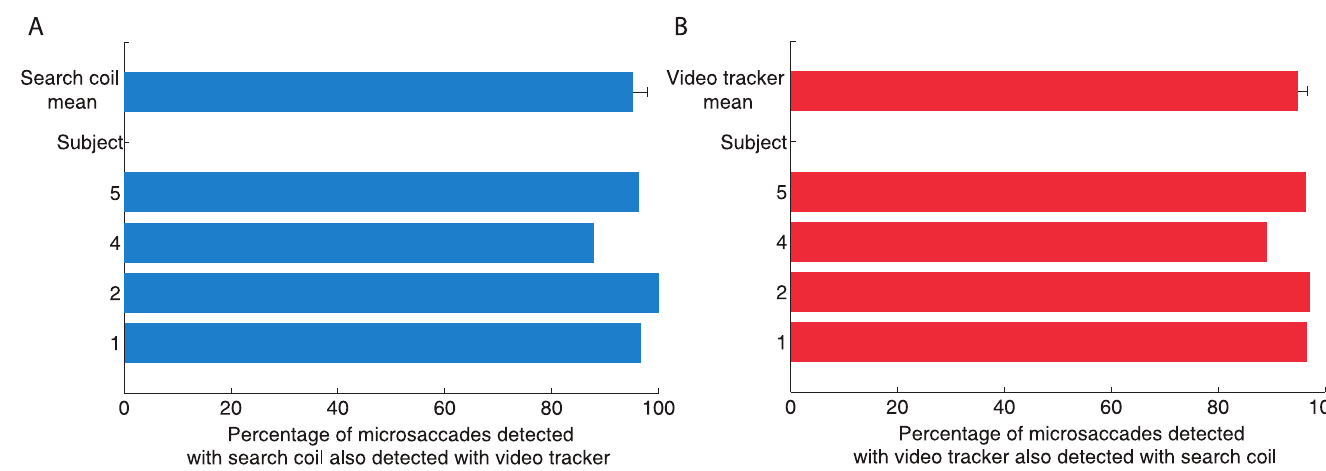
Fig 6. Coherence of detection between the two recording systems. ( A ) Percentage of microsaccades detected with the search coil that were also detected with the video tracker. ( B ) Percentage of microsaccades detected with the video tracker that were also detected with the search coil. Error bars represent the S.E.M. across participants ( n =